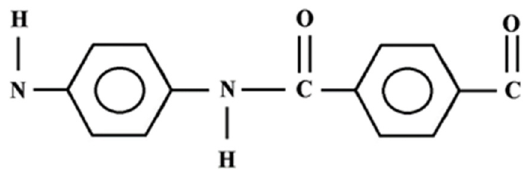
Figure 2. Primary structure of Aramid/Kevlar [33].